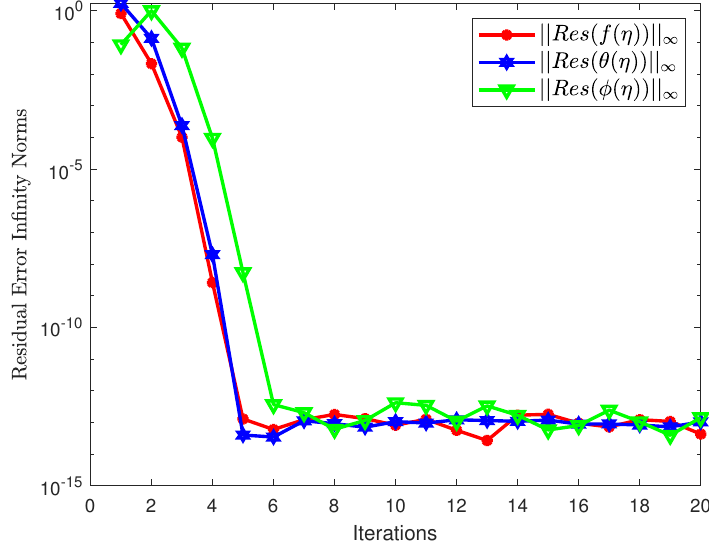
Figure 2. Accuracy graphs of f , θ and φ .